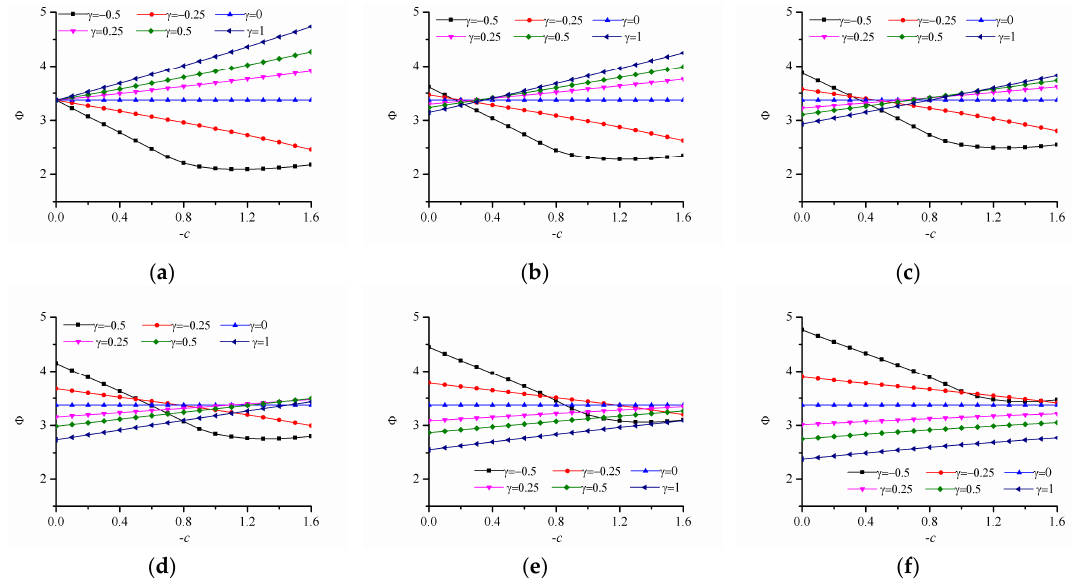
Figure 12. Variation of the failure index with different strength-modulus exponent ratio for the power-law inhomogeneous variation of r-FGM when c < 0. ( a ) δ = 0; ( b ) δ = 0.1; ( c ) δ = 0.2; ( d ) δ = 0.3; ( e ) δ = 0.4; ( f ) δ =